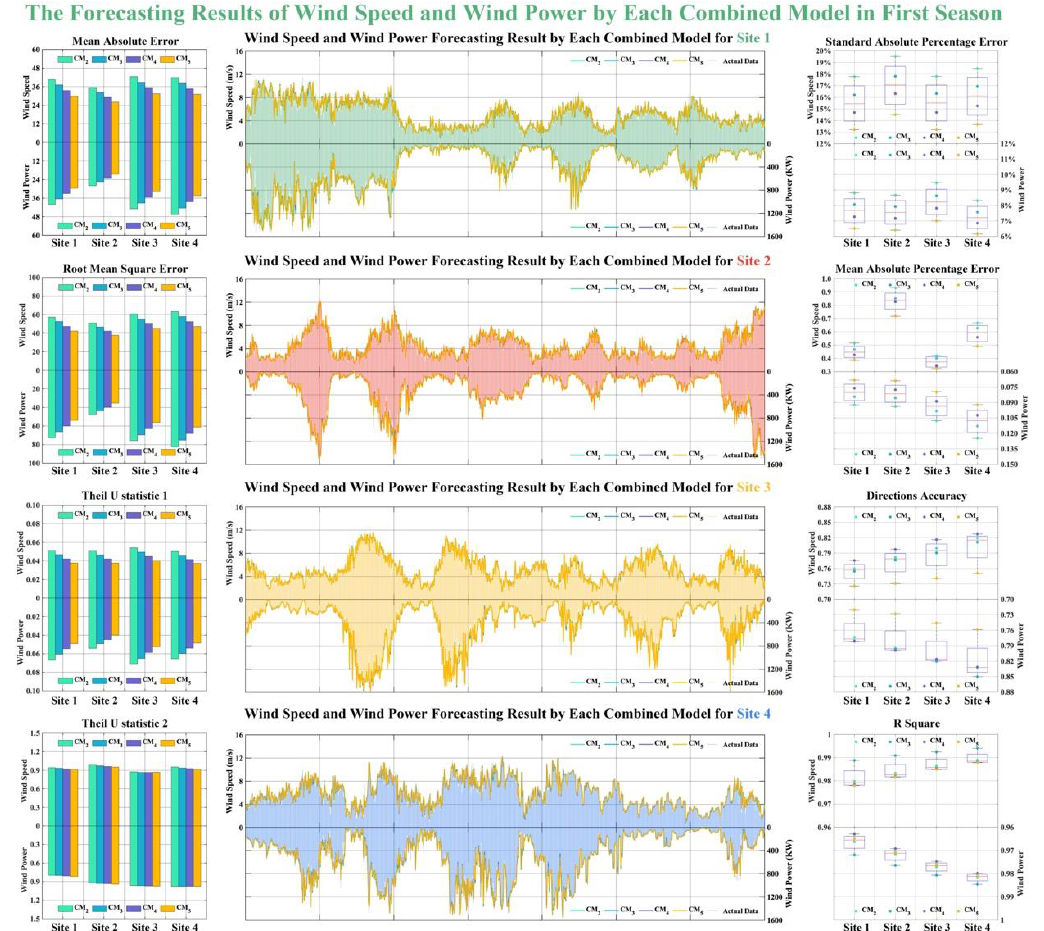
Figure 2. Wind speed and wind power forecasting result in first